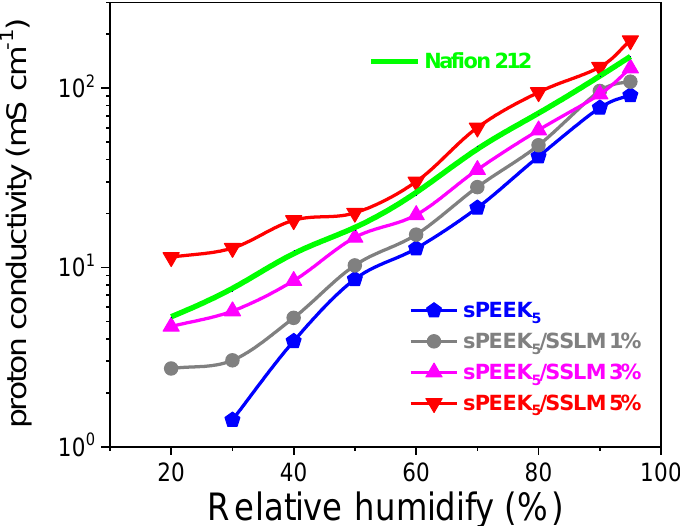
Figure 11. Proton conductivity (mS cm −1 ) of sPEEK membranes and Nafion 212 at 90 °C as a function of RH. Table 2. Comparison of the proton conductivity of SPEEK/SSLM 5% membrane with state-of-the-art membranes.